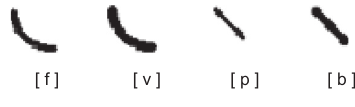
Figure 1. Pitman Shorthand.